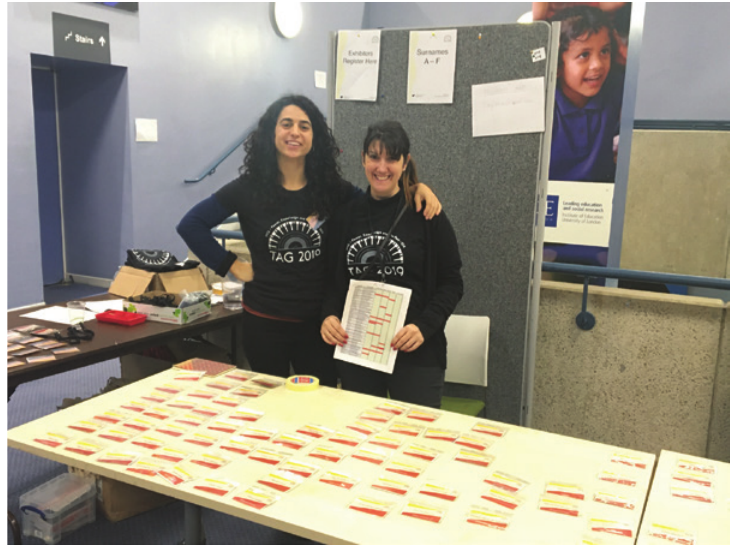
Figure 1 TAG volunteers at the registration desk. (Image credit: Andrew Gardner and Edith